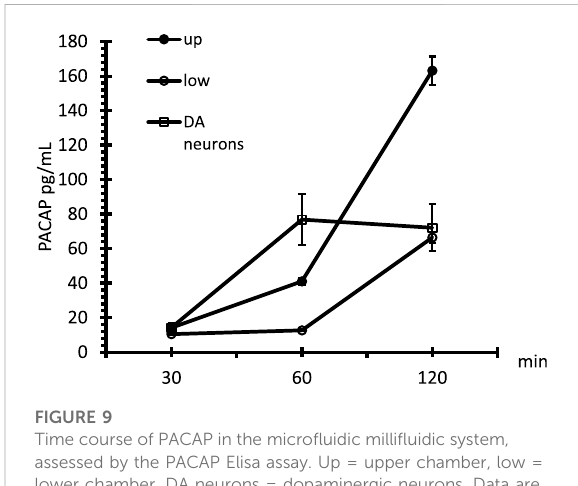
FIGURE 9 Time course of PACAP in the micro fl uidic milli fl uidic system, assessed by the PACAP Elisa assay. Up = upper chamber, low = lower chamber, DA neurons = dopaminergic neurons. Data are expressed as ±SEM.